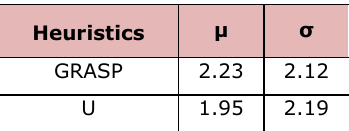
Table 6. “ μ and σ values of index heuristicsh I ,